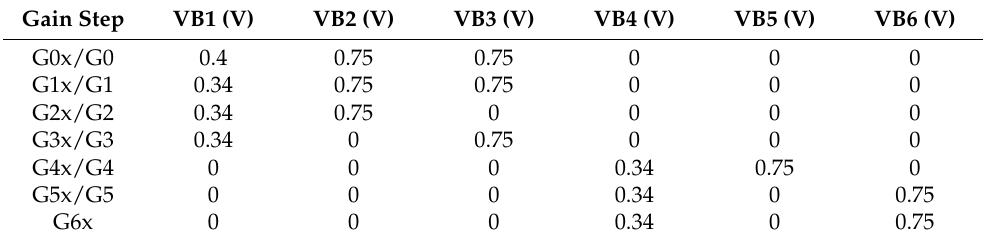
Figure 6. ( a ) Block diagram of the voltage generator, and ( b ) post-layout simulation results of the reconfigurable voltage Gen. in TT, SS, and FF corner conditions. Table 4. Biasing voltage value for all gain steps.